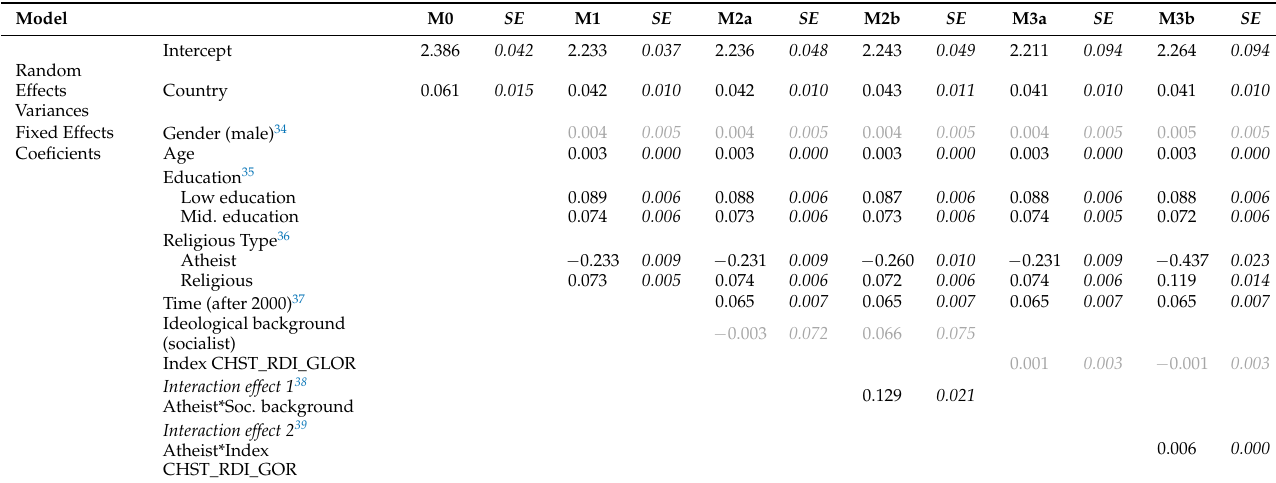
Table 1. Multilevel Analysis